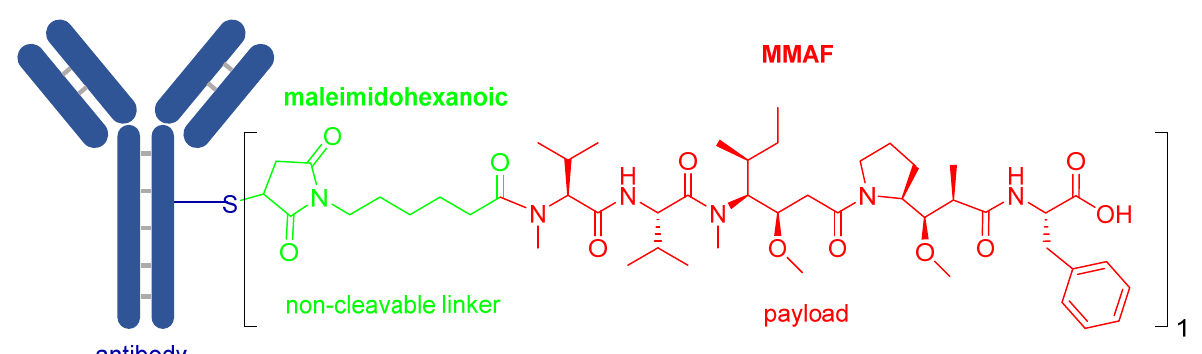
Figure 7. Chemical structure of belantamab mafodotin-blmf (Blenrep TM ).